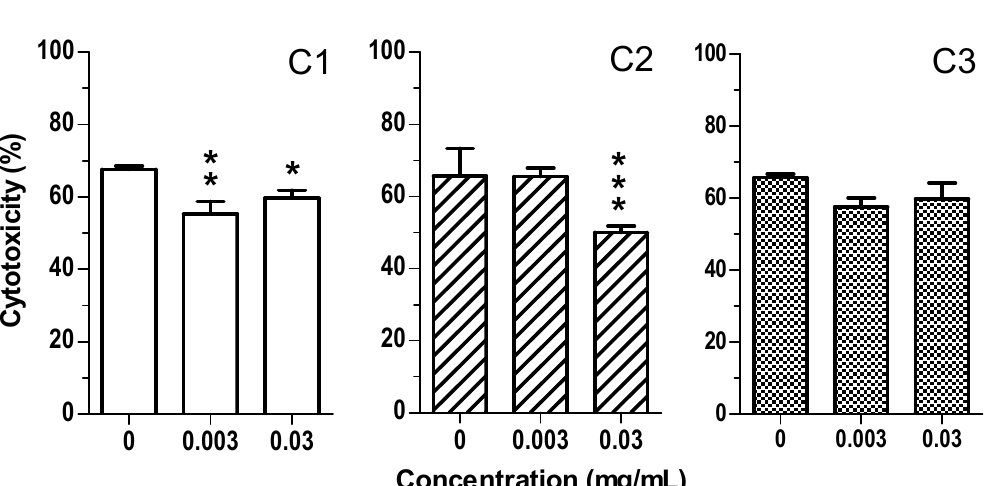
Figure 6. C1 and C2, but not C3, extracts reduce the cytotoxicity induced by UVB in HaCaT cells. Cells were treated with various concentrations of extract (0.003–0.03 mg/mL) for 1 h and then exposed to 50 mJ/cm 2 of UVB. At the end of treatment, cell viability was evaluated by MTT assay, as described in the method section. Data are expressed as percentage of control cells and expressed as mean ± SEM of four independent experiments (* p < 0.05, ** p < 0.01 and *** p < 0.001 vs. cells treated with UVA; one-way ANOVA with Dunnett post hoc test).